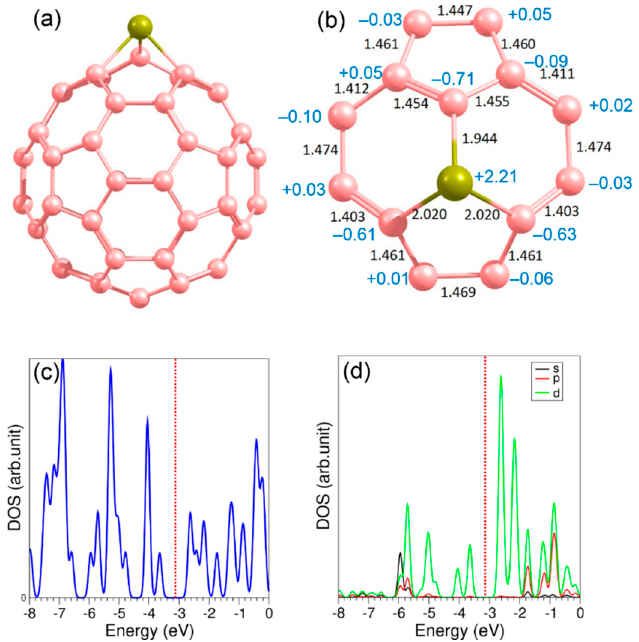
Figure 7. Relaxed structure of ( a ) Ti atom doped-C 60 , ( b ) bond lengths (Ti-C and C-C) and Bader charges on the Ti atom and the adjacent C atoms directly bonded to it, ( c ) total DOS plot and ( d ) atomic DOS plot of Ti.